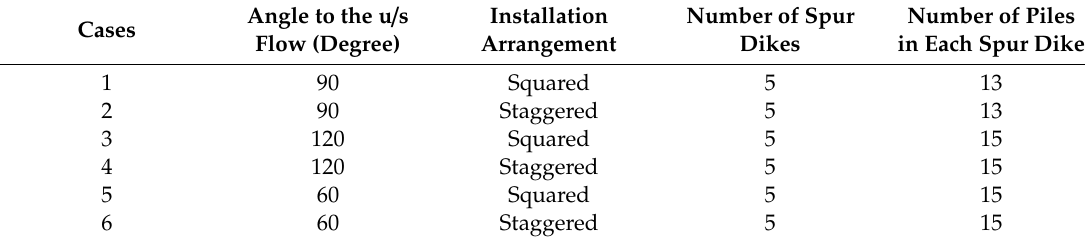
Table 1. Experimental case